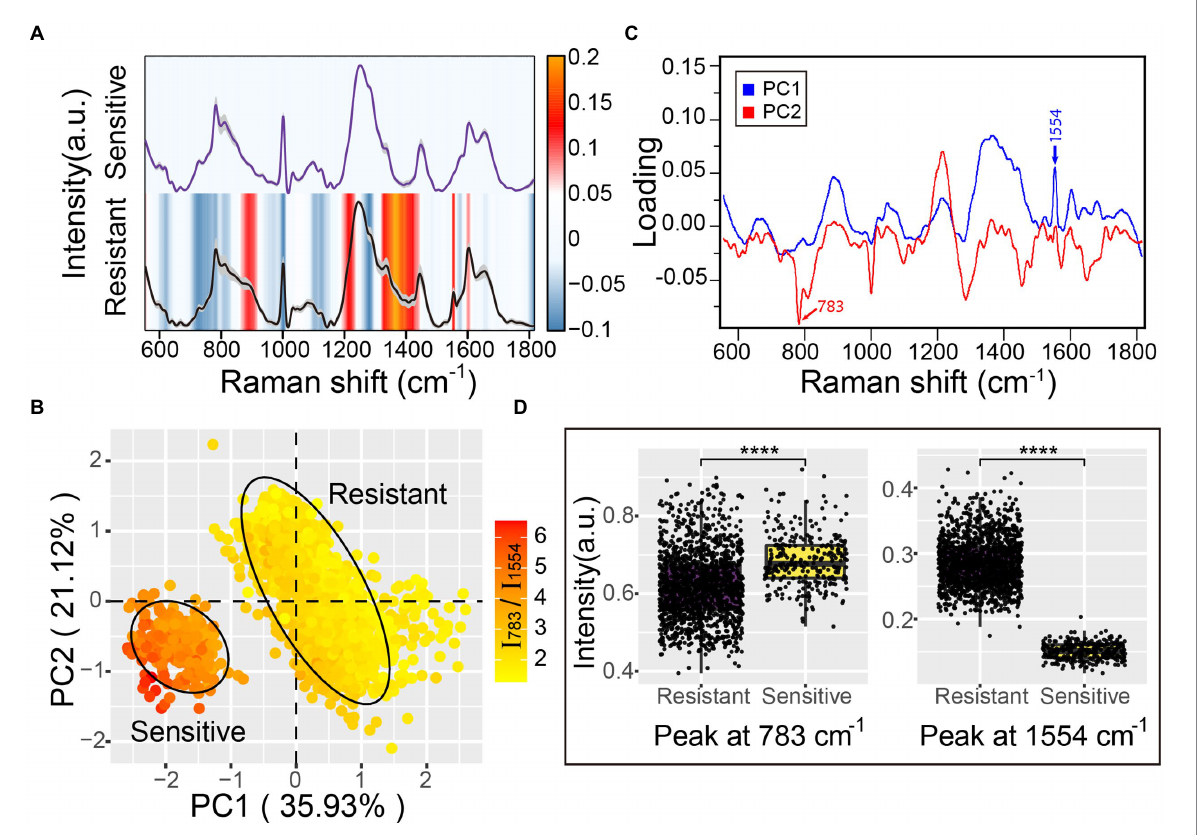
FIGURE 4 Antibiotic resistance characteristics of A. baumannii single-cell Raman spectra. (A) Raman spectra of antibiotic-sensitive and antibiotic-resistant A. baumannii . The average Raman spectra are shown by a solid line and the standard deviations are represented by the gray shadow. The heatmaps indicate the spectral difference between antibiotic-resistant and antibiotic-sensitive bacteria. (B) Principal component analysis between antibiotic- resistant and antibiotic-sensitive strains. The explained variance of the first two PCs are 35.93 and 21.12%, respectively. The confidence ellipse of each strain is 0.95. The color gradient represents the intensity ratio of the Raman peaks at 783 cm − 1 and 1,554 cm − 1 (I 783 /I 1554 ). (C) The loading of PC1 and PC2 in PCA analysis. (D) Raman intensity of antibiotic-resistant and antibiotic-sensitive strains at the 783 cm − 1 and 1,554 cm − 1 peaks. Box plots represent the median and first and third quartiles, with the whiskers representing the minimum and maximum values within 1.5 interquartile ranges from the first and third quartiles. Two-sided t -tests were applied to compare the statistical significance between antibiotic-resistant and antibiotic- sensitive strains. ****p ≤ 0.0001. Each dot represents the Raman intensity of a single A. baumannii